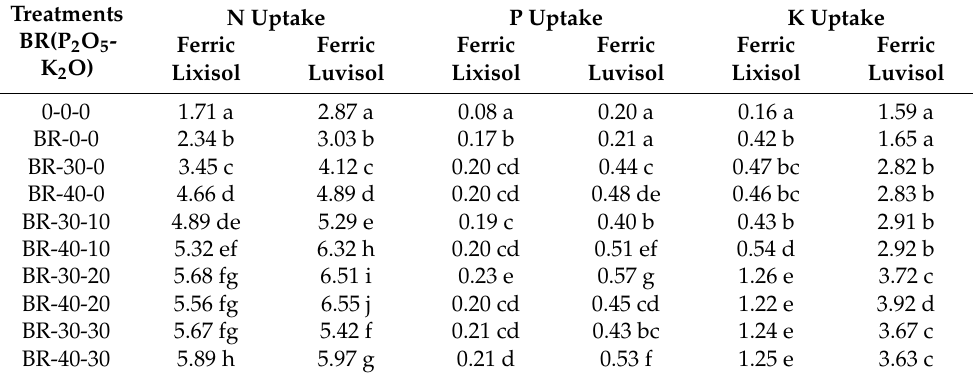
Table 3. Effect of inoculant and fertilizer application on cowpea grain N, P and K uptake.